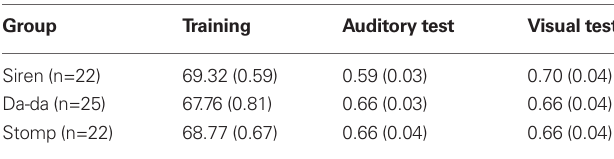
Table 1 | For each of the three secondary tasks, number correct during training (standard errors in parentheses), and proportion correct during the test